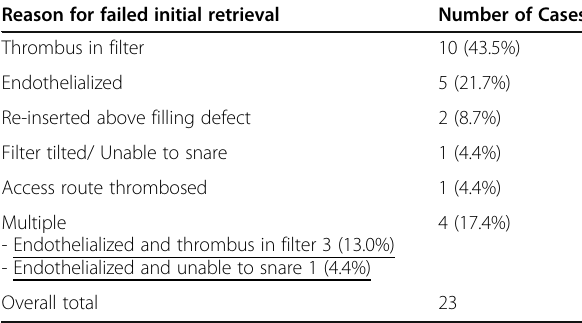
Table 5 Reasons for failed initial retrieval ( n = 23) Reason for failed initial retrieval Number of Cases Thrombus in